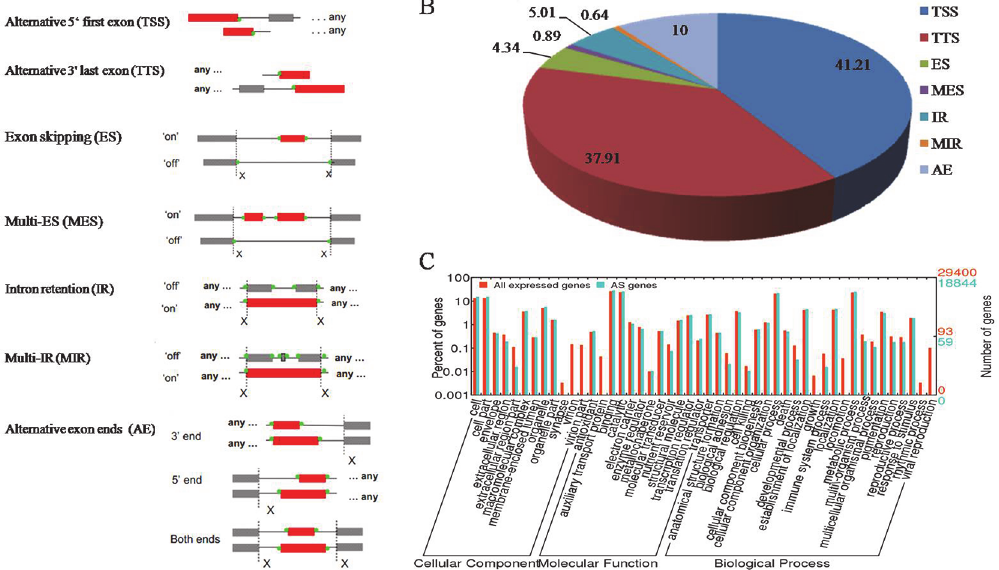
Fig 6. Statistics of the different AS events and GO analysis of AS genes. (A) Diagram of different types of AS events. (B) Proportion of different types of AS events. (C) GO analysis of AS genes using all expressed genes for lotus as the